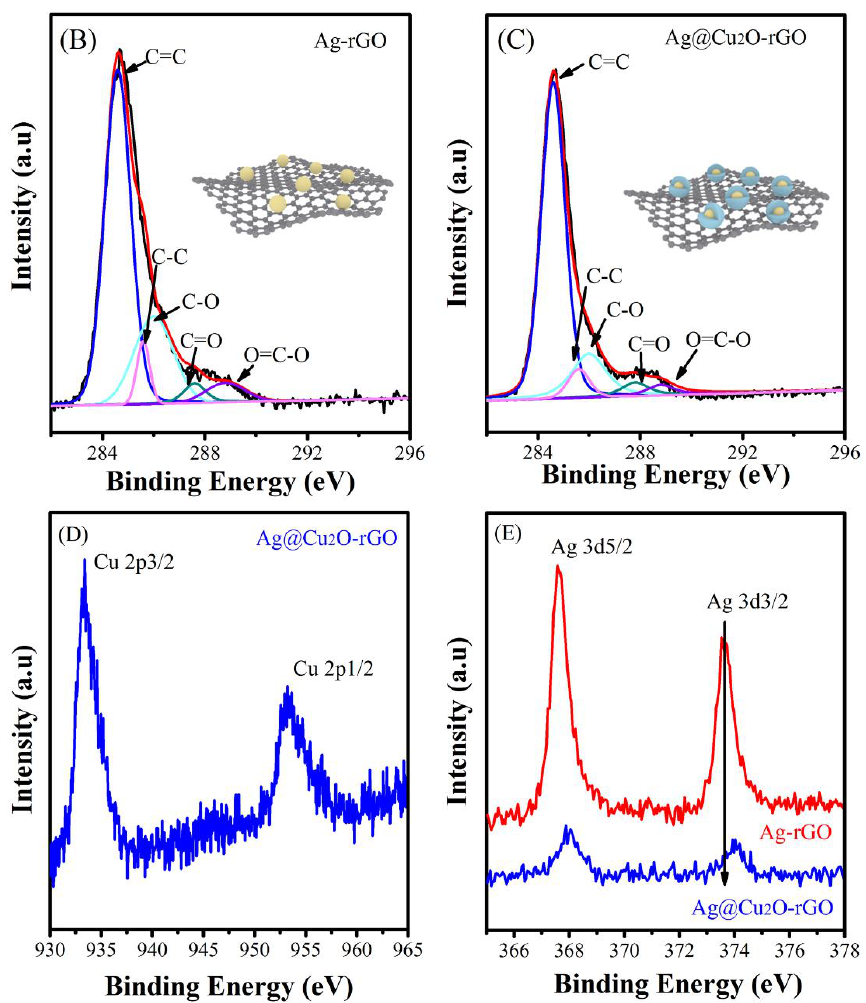
Figure 4. The X-ray photoelectron spectroscopy (XPS) survey spectra ( A ) of Ag-rGO and Ag@Cu 2 O- rGO; high-resolution XPS spectra of C 1s for ( B ) Ag-rGO and ( C ) Ag@Cu 2 O-rGO. The XPS survey spectra of Cu element and Ag element ( D ) in Ag@Cu 2 O-rGO.